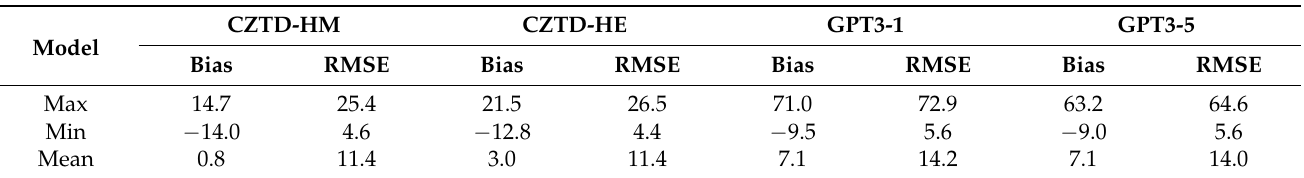
Table 3. Error statistics of spatial interpolation for GGOS gridded ZTD compared with GNSS data (unit